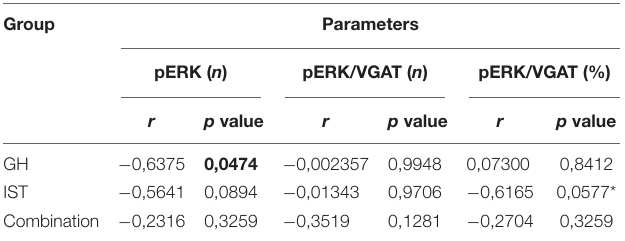
TABLE 3 | Overview of correlation coefficients between aggressive behavior, displayed by group-housed (GH) or isolated and trained (IST) females during the FIT, and the number of pERK + cells and pERK + /VGAT + (number of cells and percentage of colocalization). Group